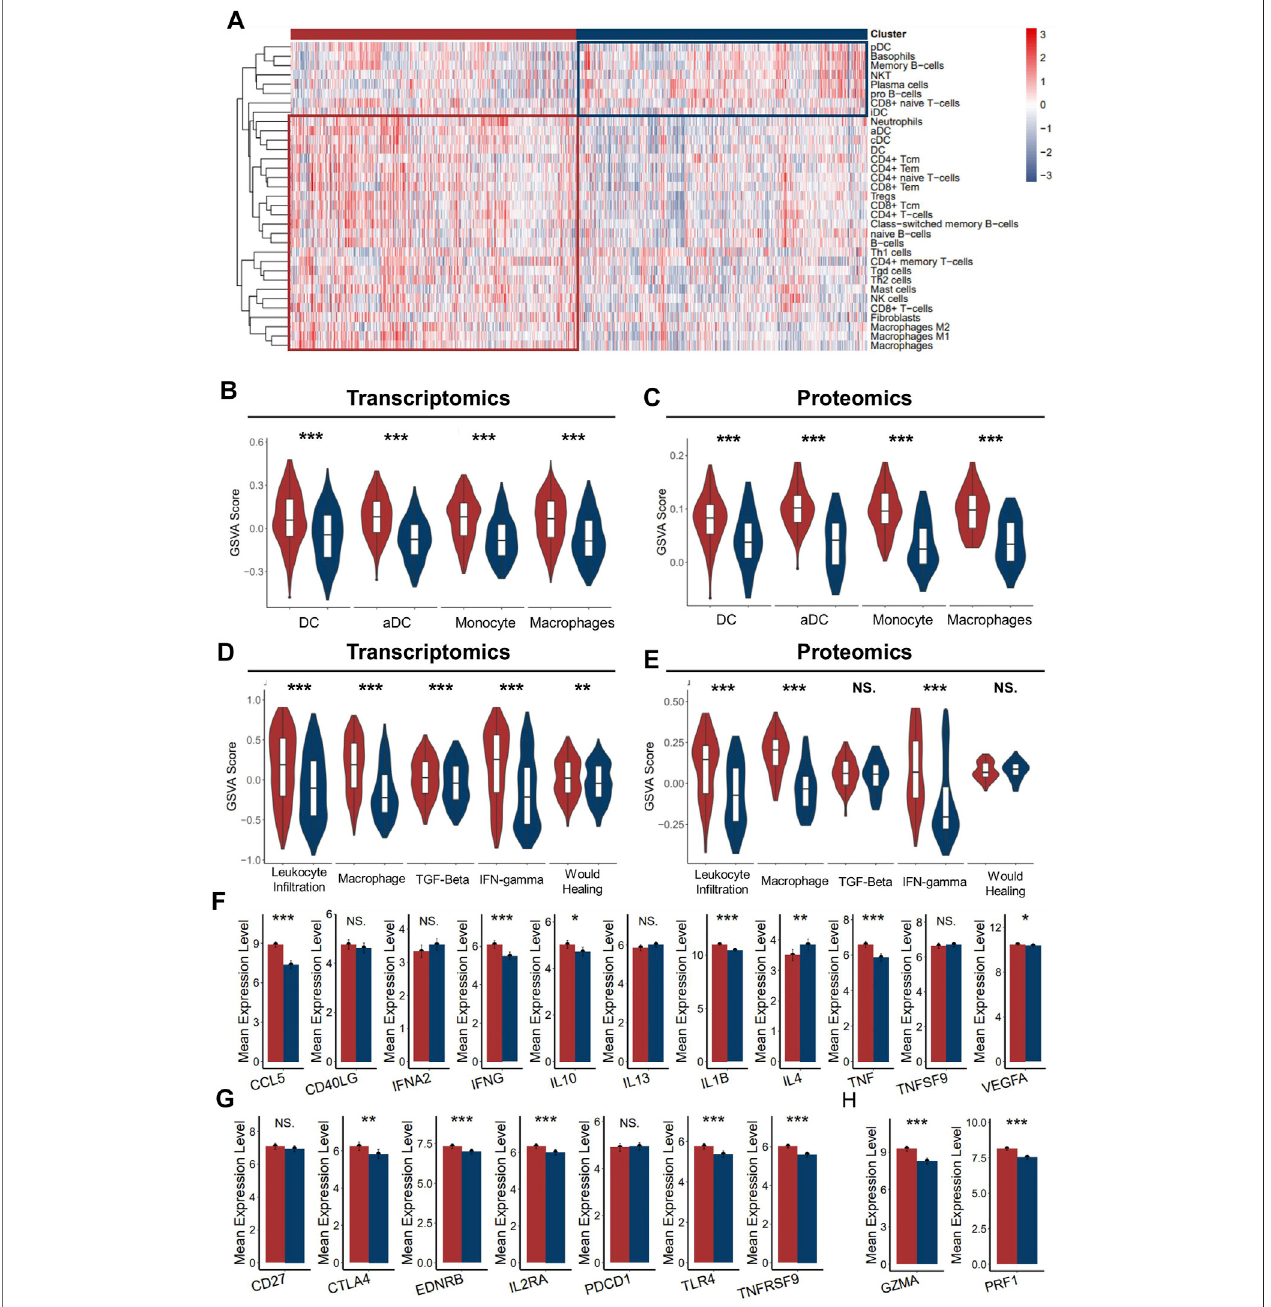
FIGURE 4| Immune in fi ltration characteristics of twoICD clusters. (A) Heatmap presentsthe fi ltration of immune cells in twoICD clusters (B,C) . The enrichmentof major antigen-presenting cells of two clusters in the transcriptomics level (B) and proteomics level (C – E) . GSVA scores of fi ve immune signatures of two ICD clusters in the transcriptomics level (D) and proteomics level (E,F) . The mean expression of immunoregulator ligands of two ICD clusters in the transcriptomics level. (G) Mean expression of immunoregulator receptors of two ICD clusters in the transcriptomics level. (H) Mean expression of cytotoxic activity signature of two ICD-score clusters in the transcriptomics level. (Mann – Whitney U test: NS: no statistical difference, *: p < 0.05, **: p < 0.01, ***: p < 0.0001) (red for the ICD-score high cluster; blue for the ICD-score low cluster).